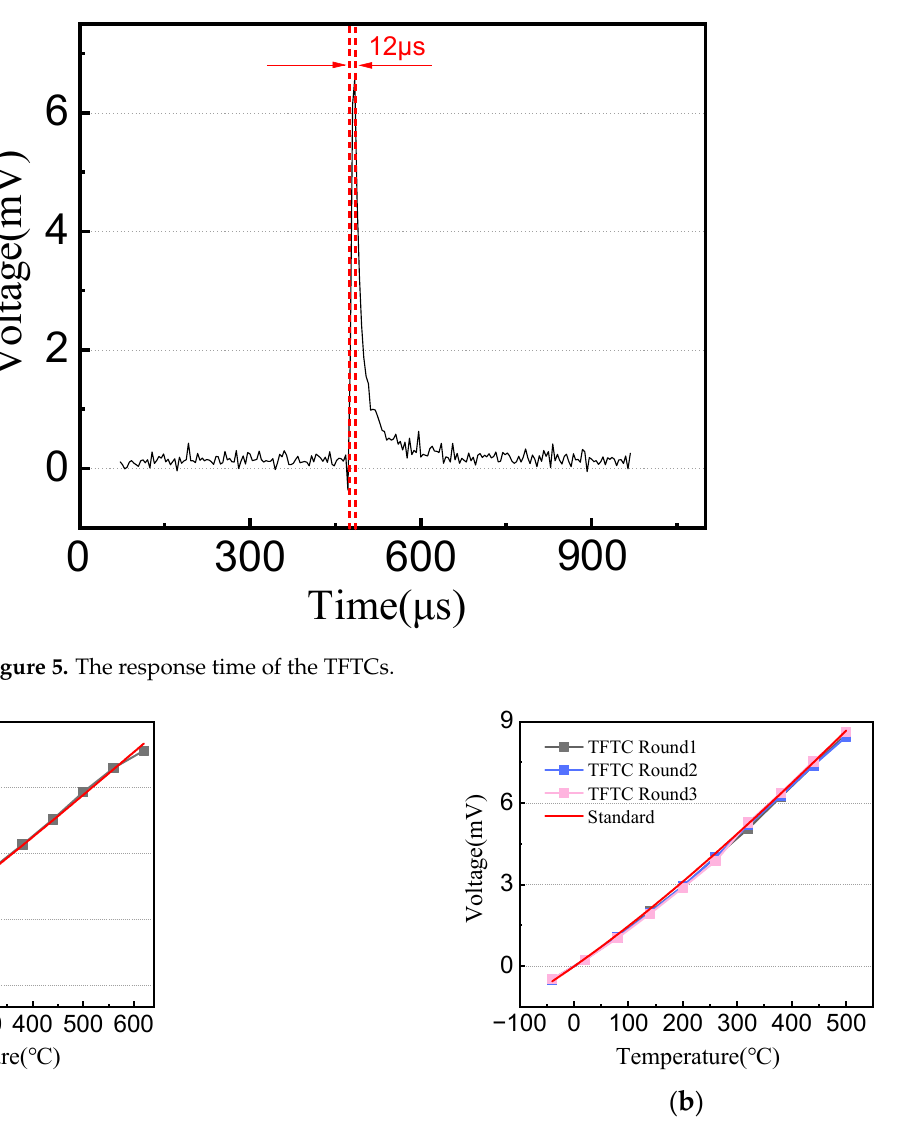
Figure 6. Comparison of voltage–temperature curves of TFTC and standard wire thermocouples. ( a ) − 40~620 °C; ( b ) − 40~500 °C.